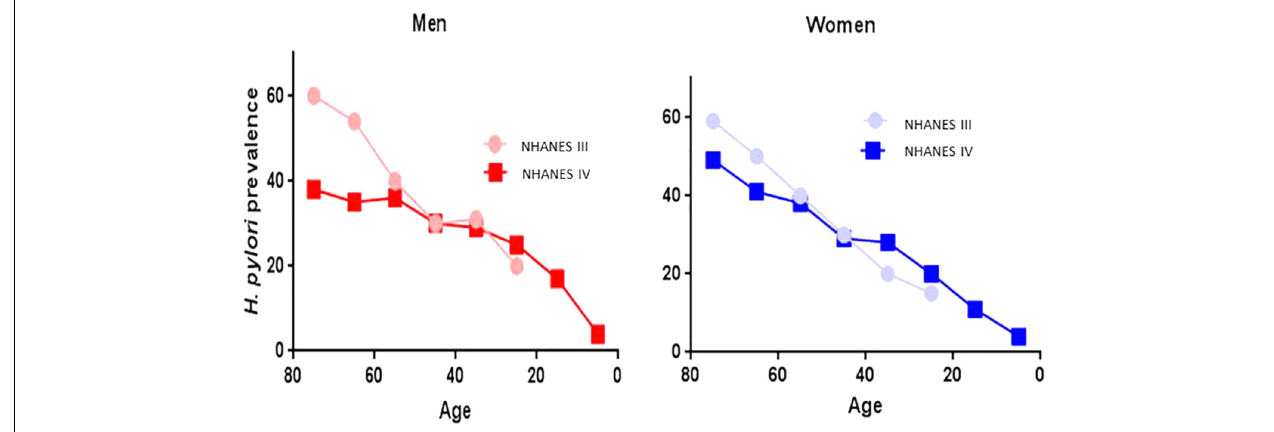
FIGURE 1 | Decline in H. pylori prevalence observed in two population studies NHANES III Phase I (1988–1991)